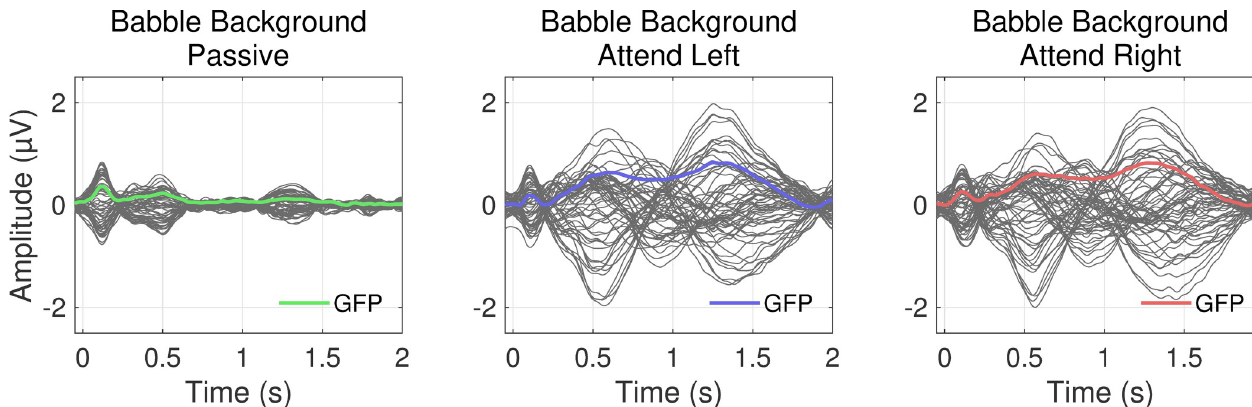
Fig 4. Average potentials measured at the scalp for three attention conditions (Passive, Attend Left, and Attend Right) in babble background. Dark grey lines represent 64 recording sites, and colored lines are the baseline-corrected global field power (GFP) across all electrodes.